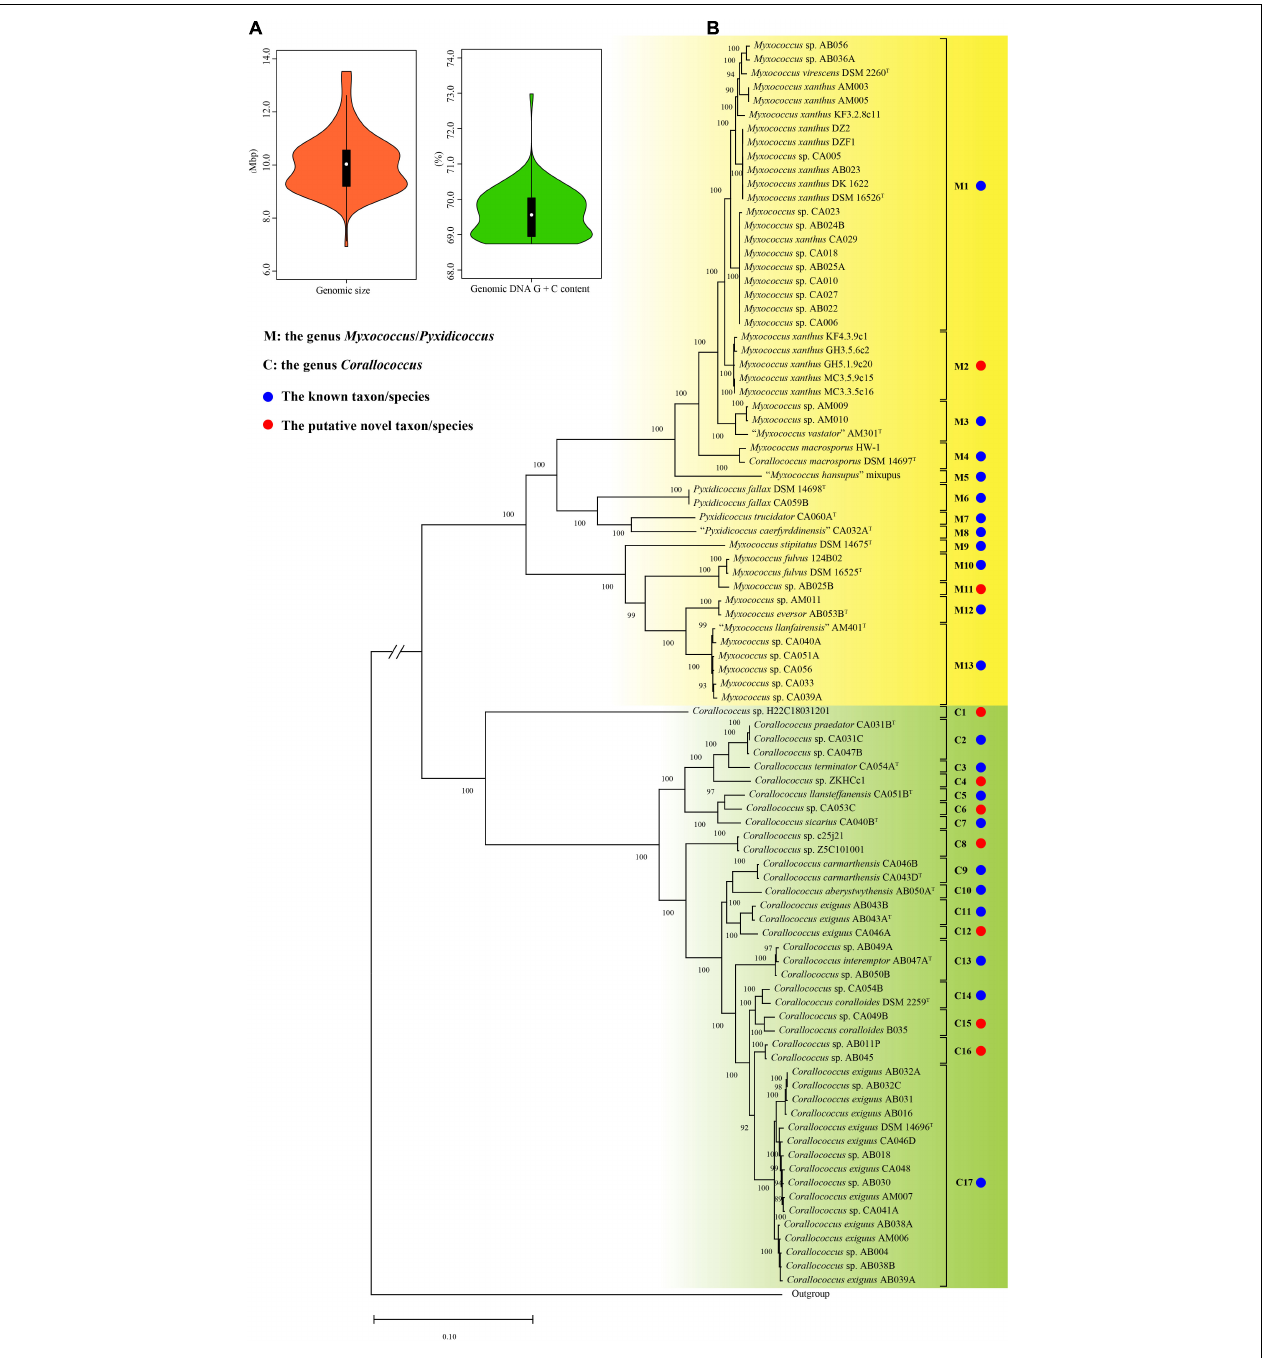
FIGURE 1 | The violin plots of genomic sizes and DNA G + C contents (A) , the maximum-likelihood (ML) phylogenetic tree of 90 strains based on 1,887 orthologous protein sequences of 91 genome sequences (B) . The ML tree was reconstructed using the IQ-TREE with the LG + F + R4 model. The species names are effectively but not yet validly published and thus are in quotation marks. Strain Aggregicoccus sp. 17bor-14 was used as an outgroup. Bootstrap values great than 80% were shown at branch points. Bar: 0.1 represents the number of substitutions per site. The branch length of the outgroup was cut down to fit the image size and indicated by parallel oblique lines